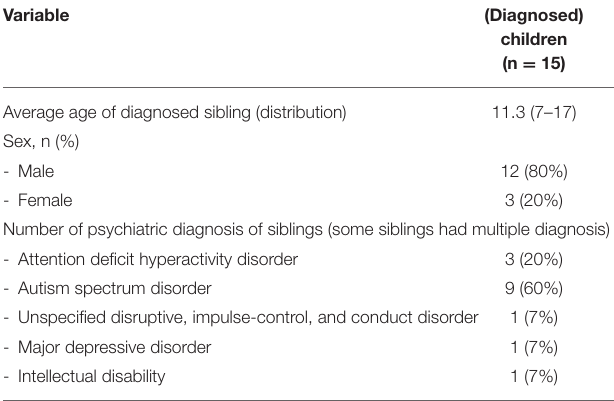
TABLE 2 | Demographics of diagnosed brothers and